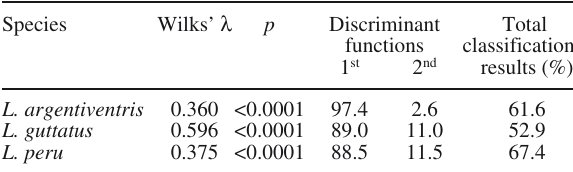
Table 3. – Discriminant analysis of fish scale form of three geo- graphic variants (PV, Puerto Vallarta; MA, Manzanillo; and CC, Caleta de Campos) of three lutjanid species. The percentage of the total variance explained by the first and second discriminant func- tions is shown. Total classification success for cross-validated pre- dicted geographic variant